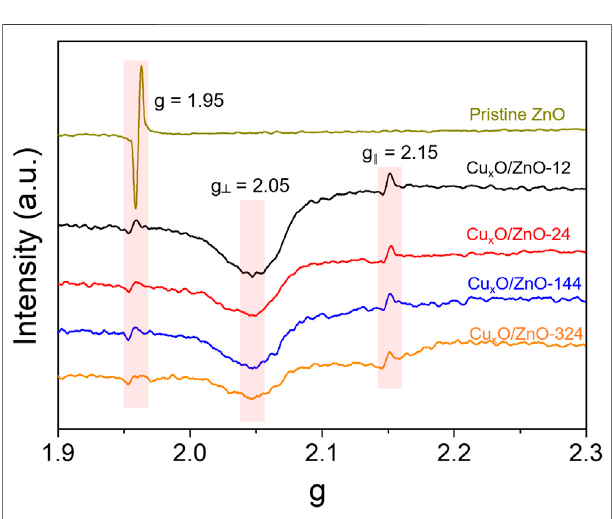
FIGURE5| Electronparamagneticresonancepro fi lesoftheas-synthesized Cu x O/ZnO catalysts and pristine ZnO